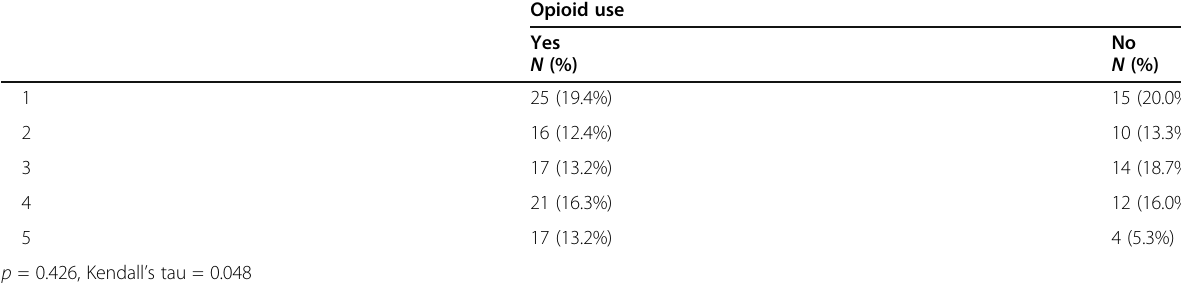
Table 7 Associations between opioid use and concerns ( n = 204)